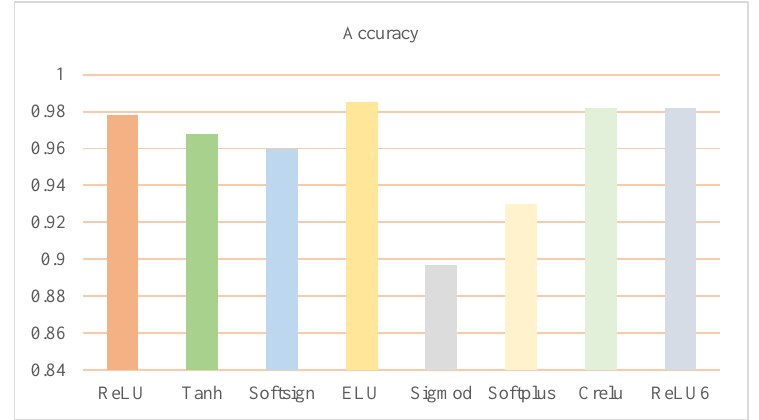
Figure 8. Performance of various activation functions.